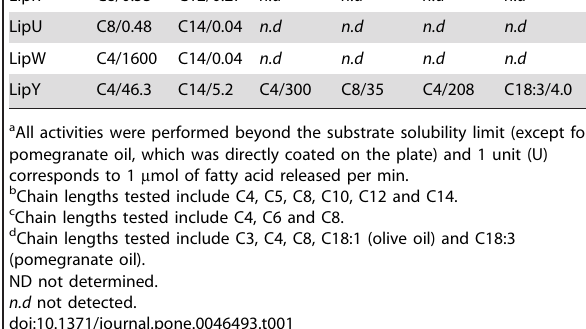
Substrate chain length/specific activities a